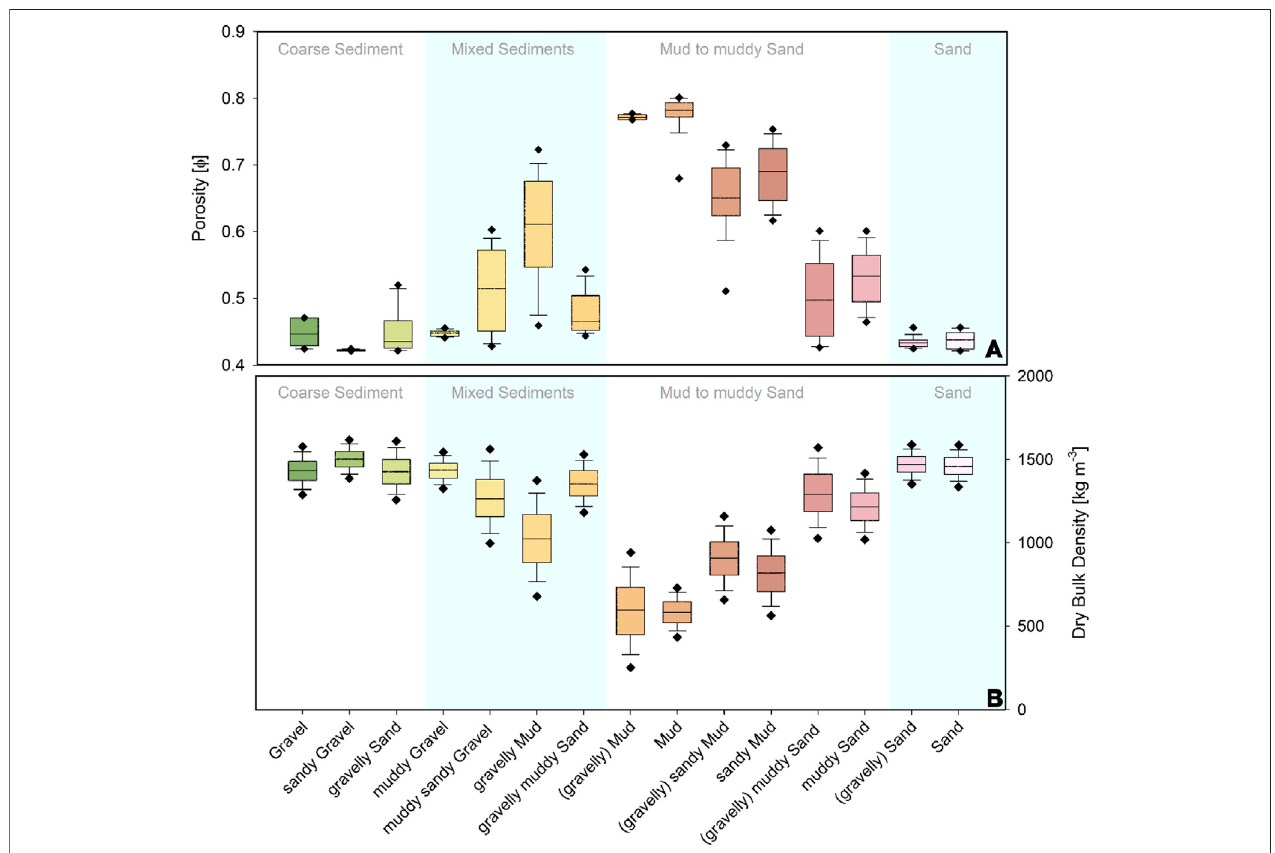
FIGURE 4 | Modeled physical property data for sediment types across the UK EEZ (A) Porosity [ Φ ] (B) Dry bulk density [kg m − 3 ].